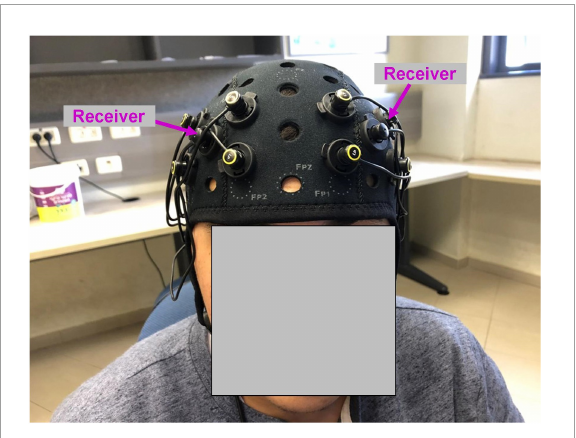
FIGURE1 Functional near-infrared spectroscopy montage used in the study. Four emitters in each hemisphere were positioned at the corners of the square around the receiver (marked with magenta arrows). The position of the receiver was AF3 (left hemisphere) and AF4 (right hemisphere) according to 10–20 EEG